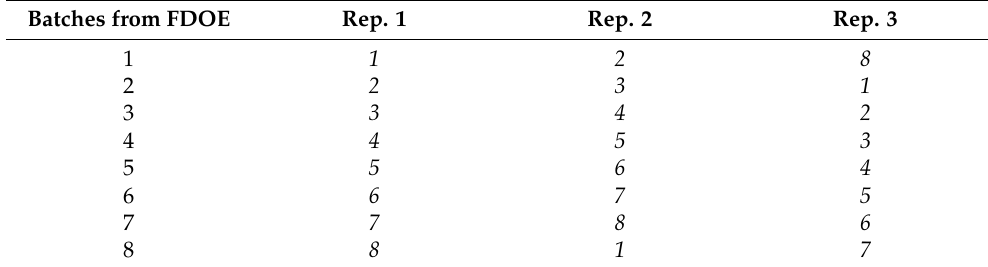
Table 1. Latin square design used to randomize the cooking of the eight batches of biscuits, according to the FDOE